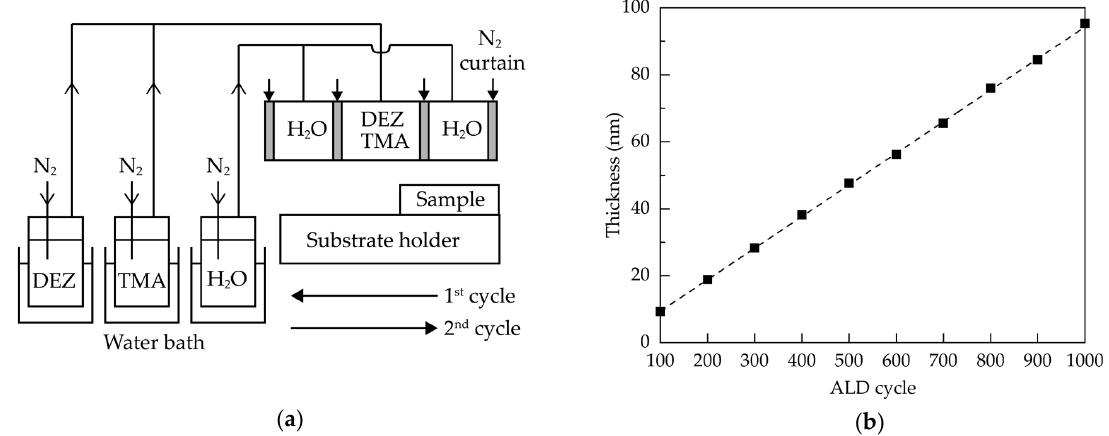
Figure 6. ( a ) Schematic diagram of the AALD system, and ( b ) thickness of the Al:ZnO films as a function of the ALD cycle. Table 1. Deposition parameters for AALD Al:ZnO